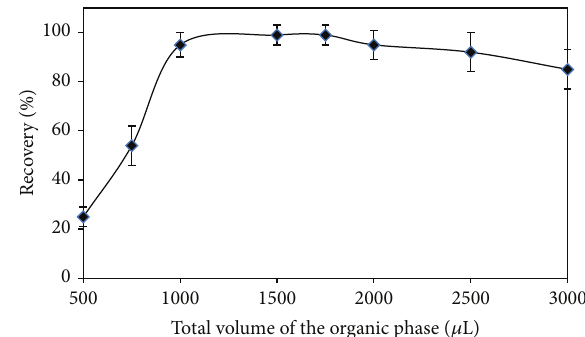
Figure 3: Effect of the volume of chloroform on the extraction efficiency of the DLLME method.